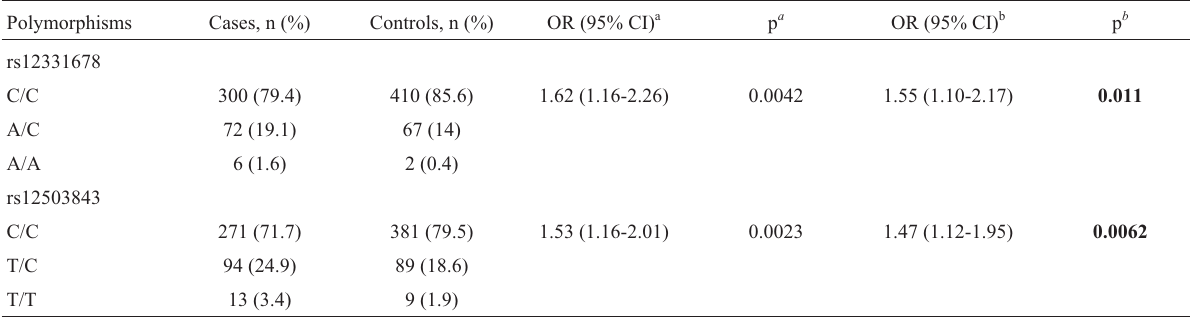
Table 5 - Independent effects of rs12331678 and rs12503843 in the overall populations.